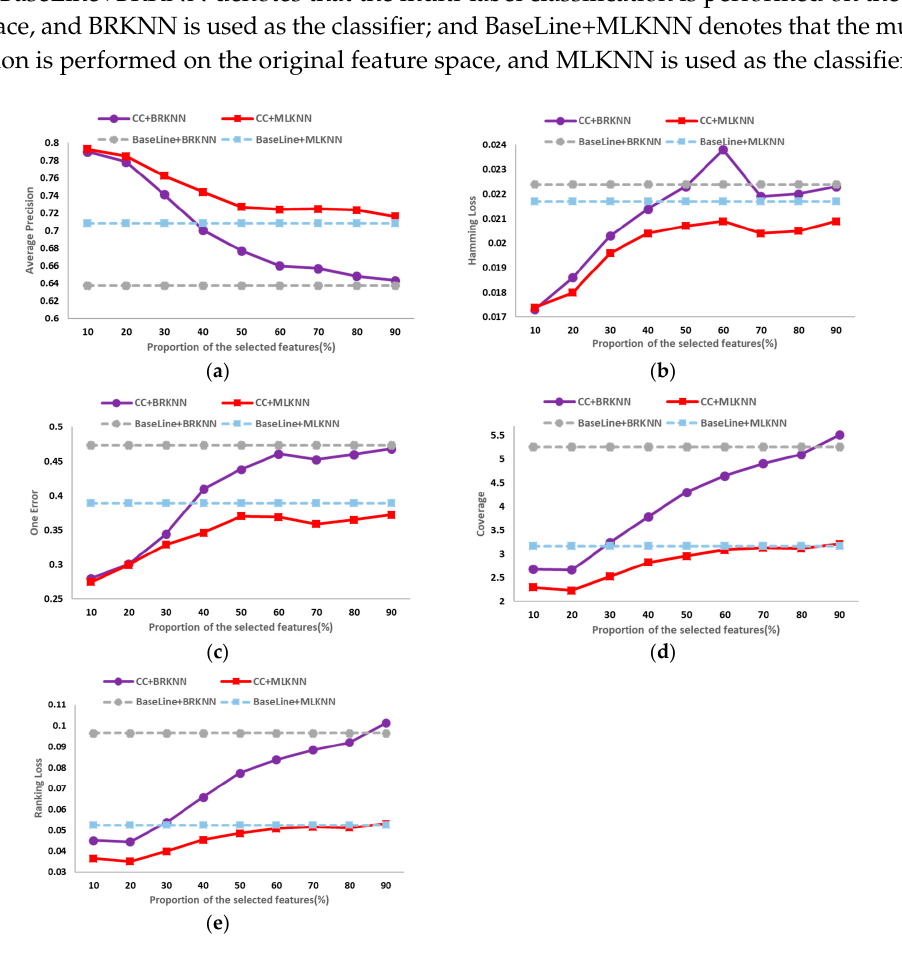
Figure 2. Experimental results on Medical data set. ( a ) Average Precision; ( b ) Hamming Loss; ( c ) One Error; ( d ) Coverage; ( e )Ranking Loss.